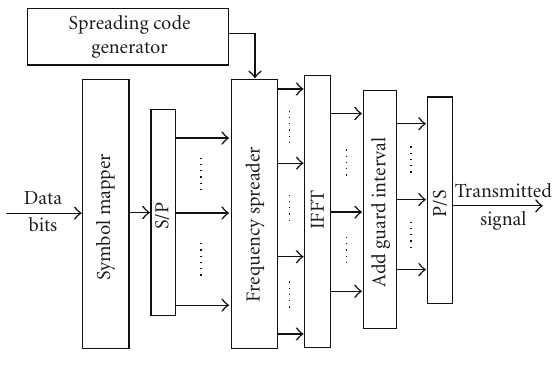
Figure 1: Transmitter of an MC-CDMA system.